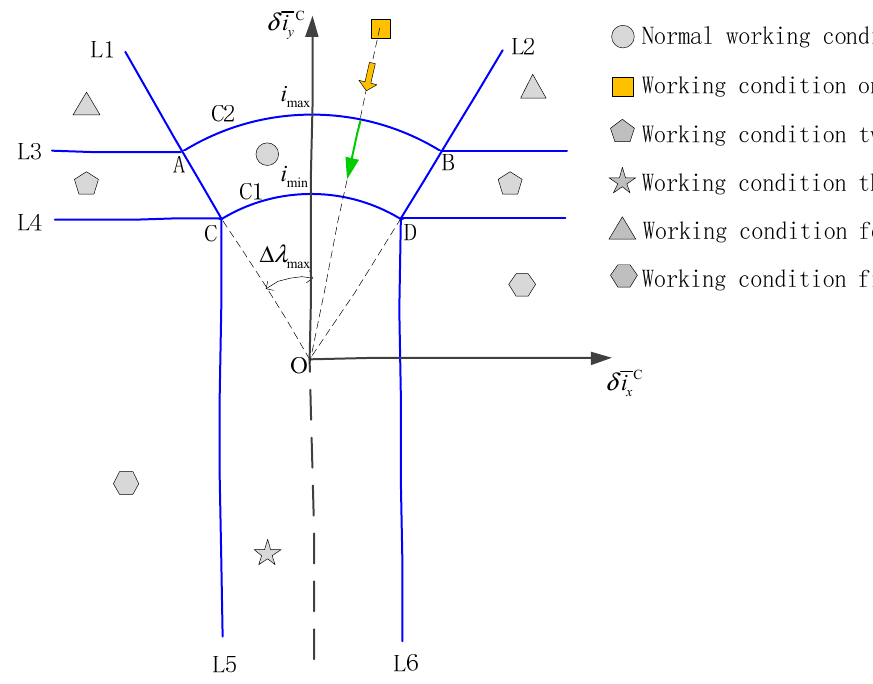
(46) (2) Working condition one Working condition one is a semi-stable zone, and the orbital inclination vector is in a positive bias state. The mean orbital inclination vector has a larger absolute value in the Y-axis direction of the inertial system and a smaller absolute value in the X-axis direction of the inertial system. Therefore, it is necessary to use the maximum orbital control capa- bility to overcome the drift of the orbital inclination vector under the perturbation, and